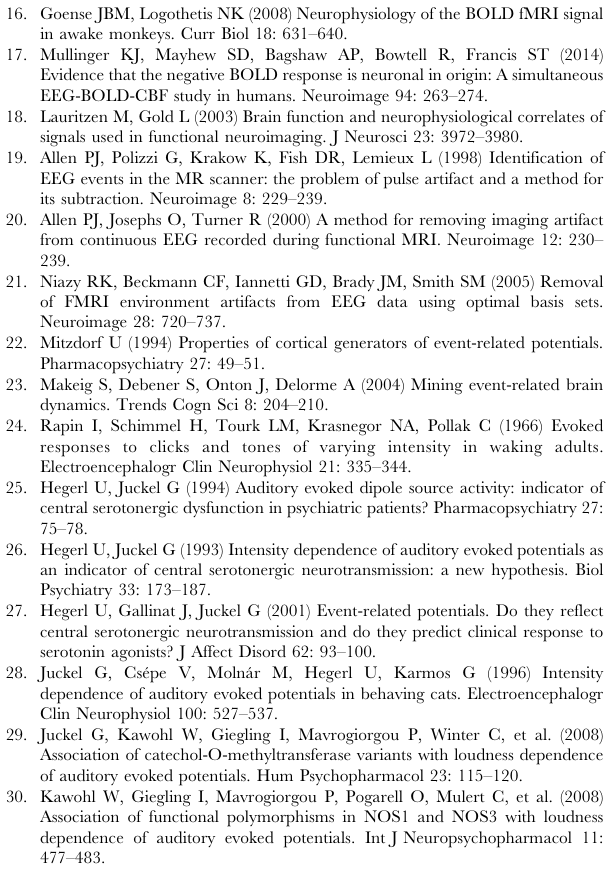
Figure S1 GLM matrix of the higher-level analysis. (TIF) Figure S2 Mean amplitude of the AEPs with the different SPLs. (TIF) Table S1 Summary of previous studies investigating the cortical response with different